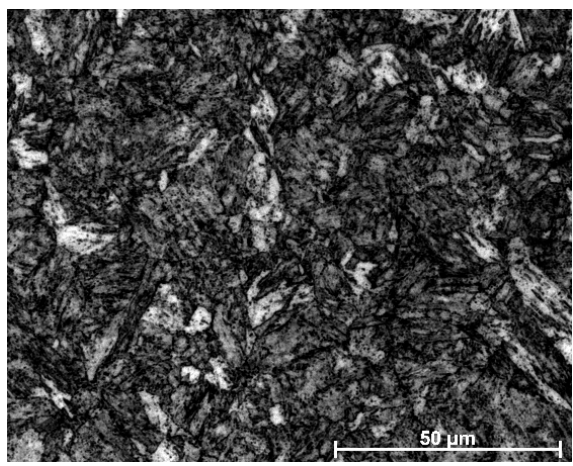
Table 2. Chemical compositions of the base metal and welding filler wire (wt. %).